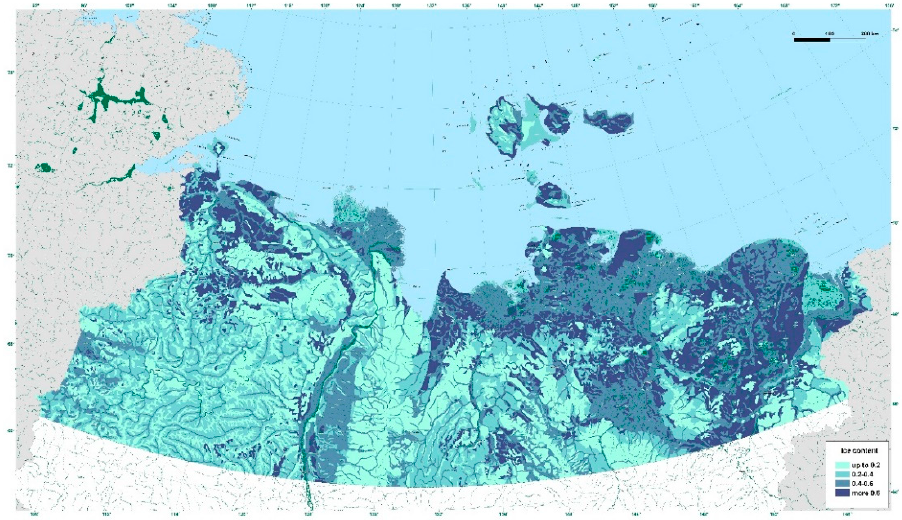
Figure 1. Ground ice content map of Arctic Yakutia